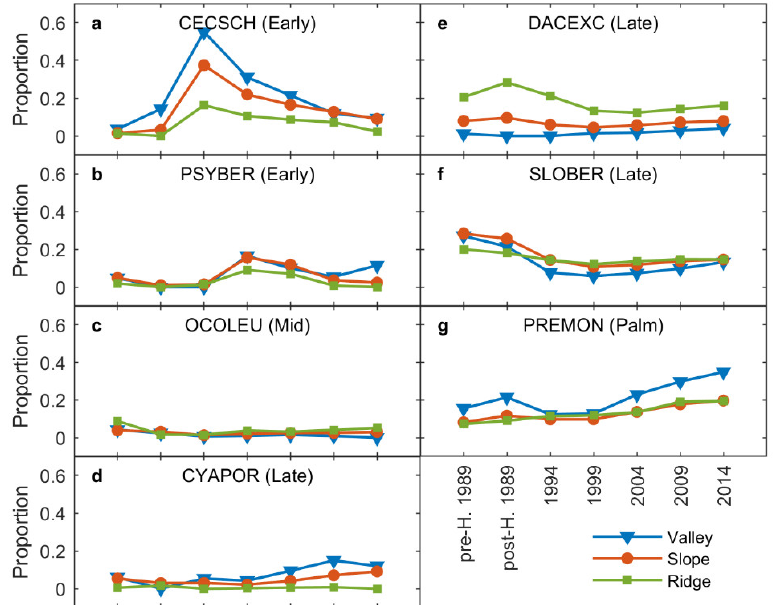
Figure 5. Mean values of species proportion across plots grouped by different topographic settings: valleys, slopes, and ridges. The x-axes are the seven census years, and the y-axes are the proportion. The seven most abundant species are ( a ) CECSCH: Cecropia Schreberiana , ( b ) PSYBER: Psychotria berteriana , ( c ) OCOLEU: Ocotea leucoxylon , ( d ) CYAPOR: Cyathea portoricensis , ( e ) DACEXC: Dacryodes excelsa , ( f ) SLOBER: Sloanea berteriana , and ( g ) PREMON: Prestoea montana . For taxonomic plant families and PFTs classification, please see Table